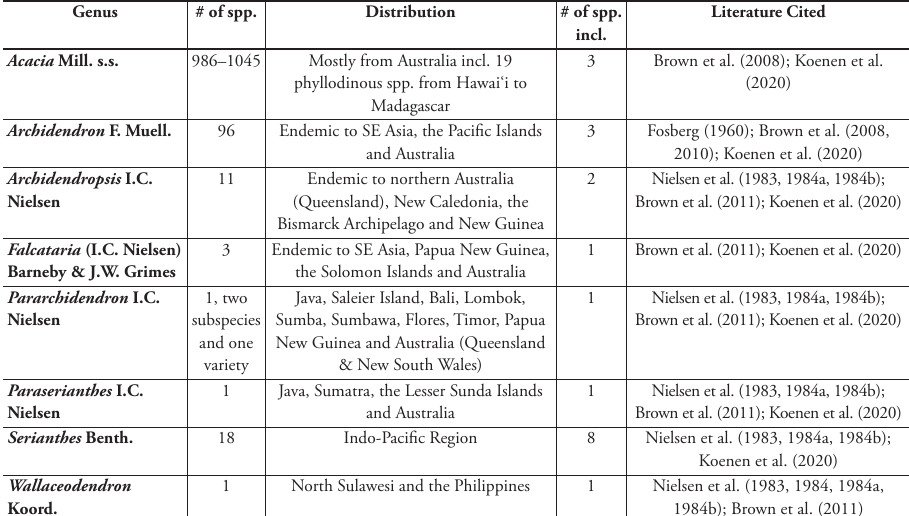
Table 1. Genera of the Archidendron clade: diversity, distribution and sampling included in the current